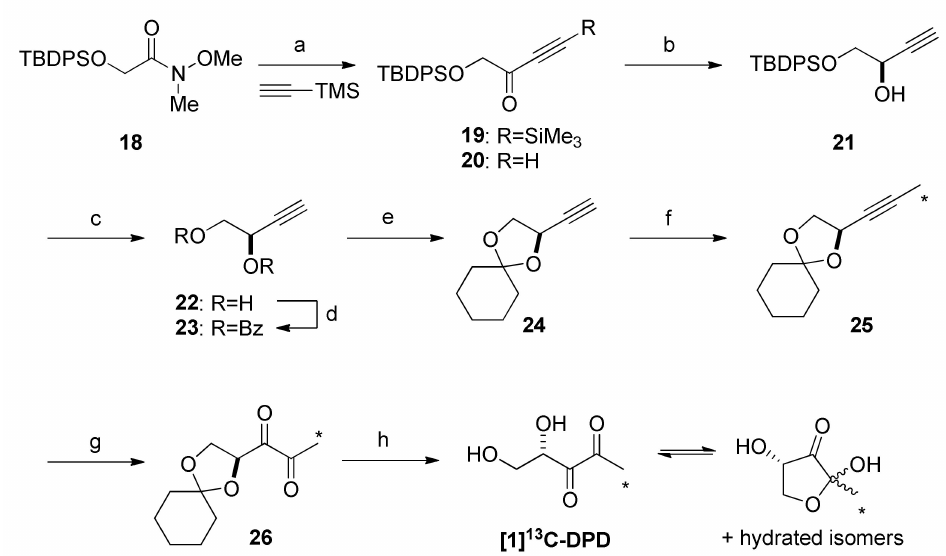
Scheme 3. Synthesis of [1- 13 C]-DPD. Reagents and conditions: ( a ) LDA, THF, from − 78 ◦ C to 0 ◦ C, 74%; ( b ) ( S )-Alpine borane, THF, rt, 67%; ( c ) TBAF, THF, rt, 71%; ( d ) BzCl, ( i -Pr) 2 NEt, DMAP, CH 2 Cl 2 , 96%; ( e ) 1,1-Dimethoxycyclohexane,